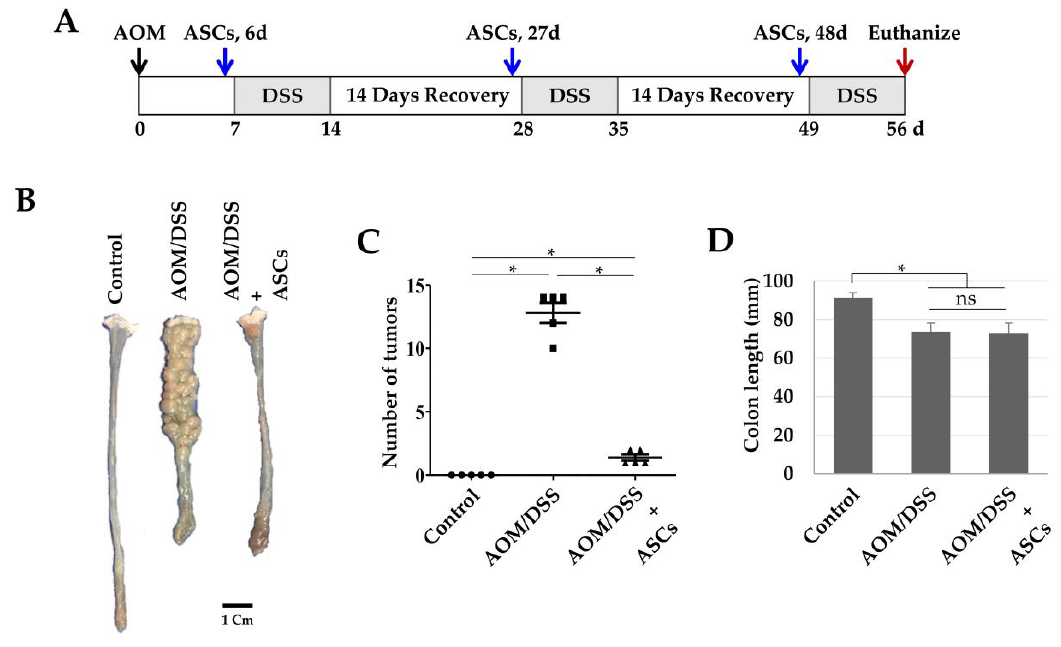
Figure 4. Suppression of colon cancer development by ASCs. ( A ) Schematic timeline for azoxymethane (AOM)/dextran sodium sulfate (DSS)-induced colon cancer and ASC transplantation. ( B ) Gross tumor burden by AOM/DSS and inhibition of tumor development by ASCs. ( C ) Reduced tumor numbers by ASC transplantation. The number of tumors in colons obtained from the control, AOM/DSS, and AOM/DSS + ASCs groups ( n = 5) were counted. * p < 0.05. ( D ) Lengths of colons obtained from the control, AOM/DSS, and AOM/DSS + ASCs groups. * p < 0.05. ns: not statistically significant.